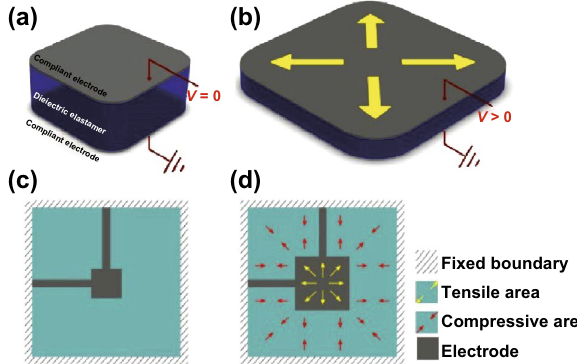
Fig. 3 The working principle of dielectric elastomer actuators (DEAs) and the classical DEAs for cellular mechanical stimulus. Adapted from Ref. [71] with permission. a The device consists of a soft dielectric elastomer sandwiched between compliant electrodes on both top and bottom sides; the actuator keeps static without voltage applied, and b the device is motivated when the voltage is applied. Similarly, for cellular mechanical loading, the DEA c keeps the origi- nal state without HV applied and d deforms underactuated and then generates two regions as tensile strain area and compressive area